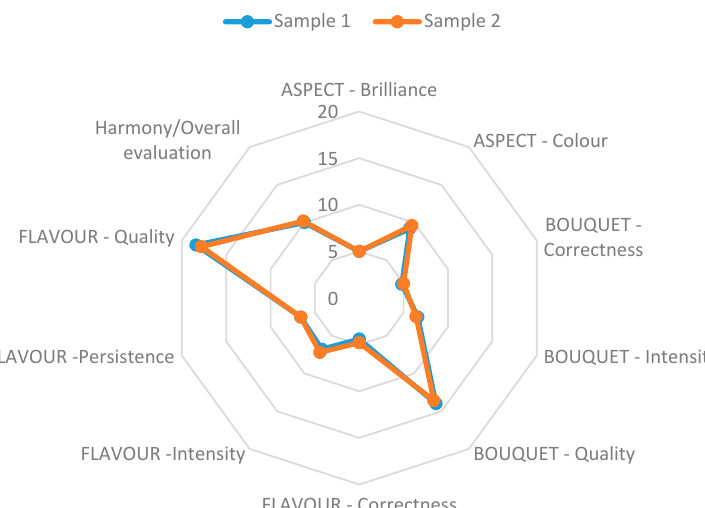
Figure 1. Results of sensory analysis of both samples .